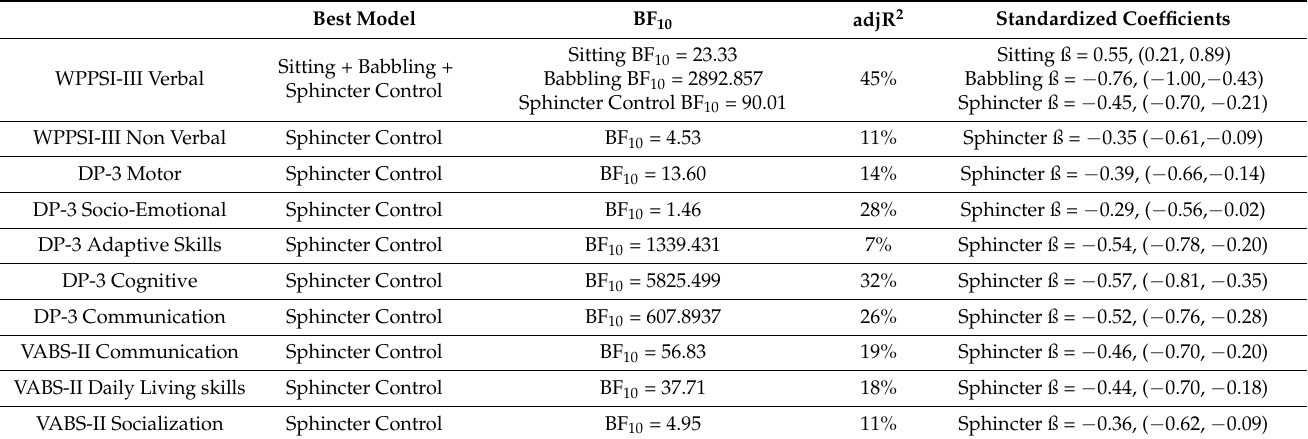
Table 7. Best model selection in the School-age group. N =